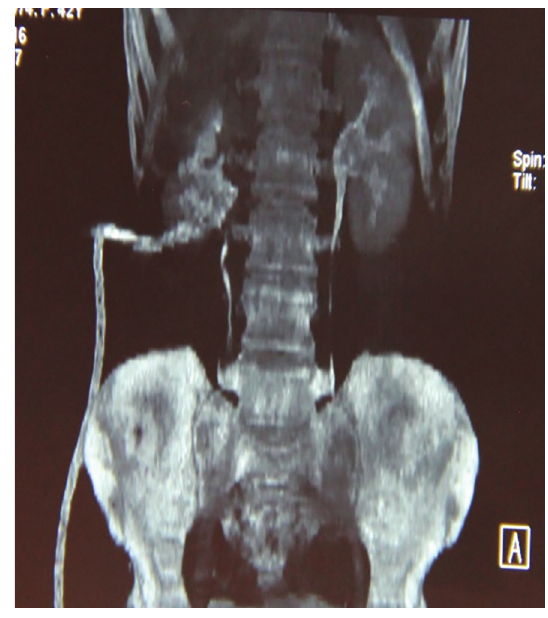
Figure 2 - CT with 3D modeling: inferior to middle-third ureter cannot be identified